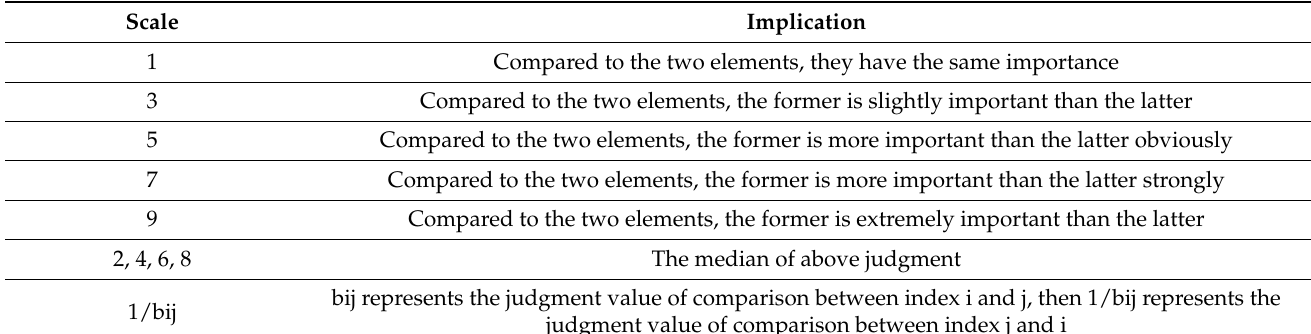
Table 5. The implication of ratio scale of 1–9.